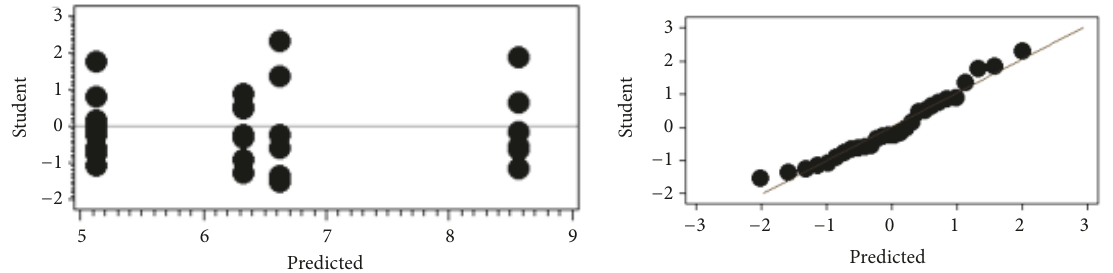
Figure 2: Plots of studentized residuals versus predicted values and versus normal quantiles for wet mix.